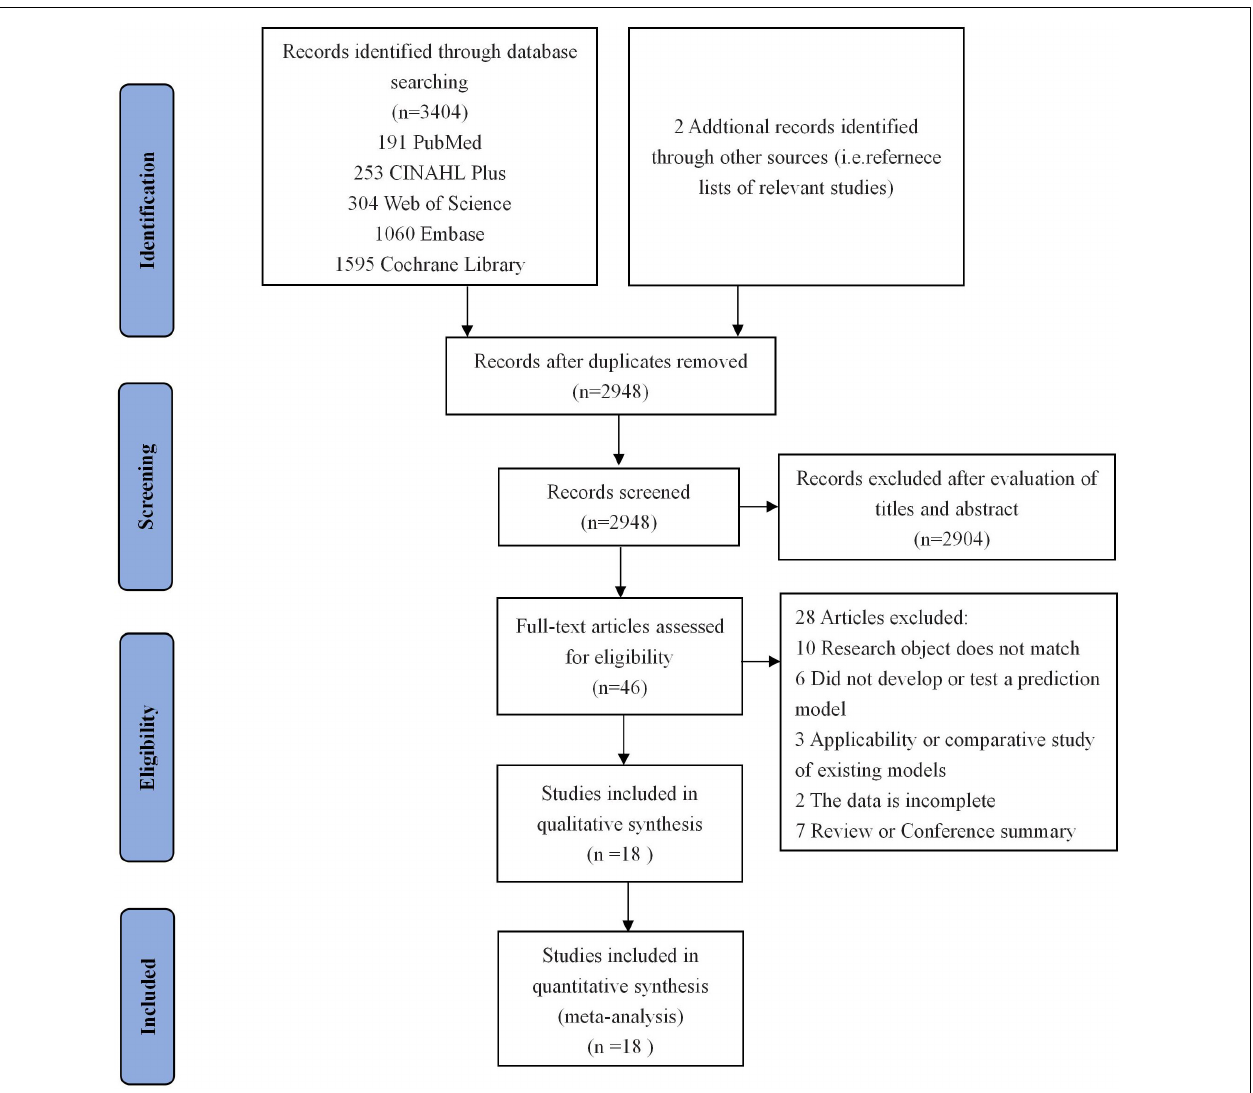
FIGURE 1 | Flow chart of study selection. Showing the process by which relevant studies retrieved from the databases were assessed and selected or excluded.